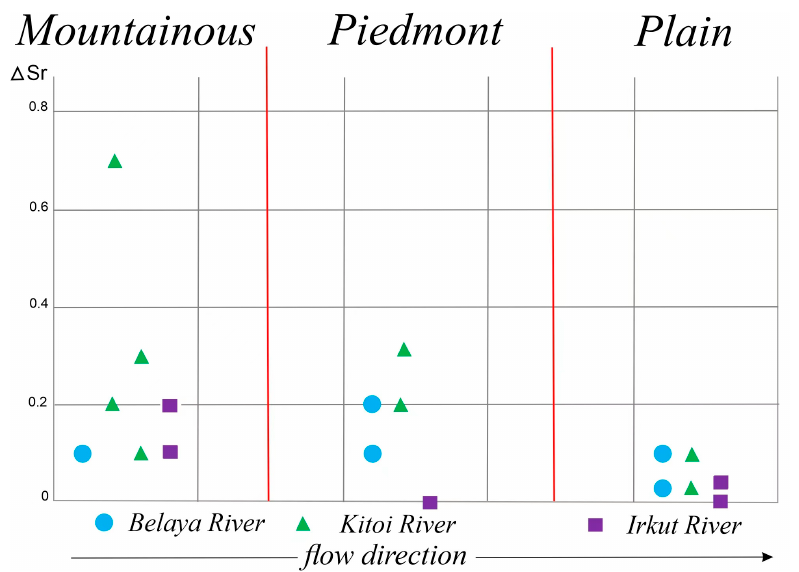
Figure 5. Distribution of indicators of relative variability of floodplain islands of the left-bank tributaries of the Angara River from 1977 to 2021 in various geodynamic areas.